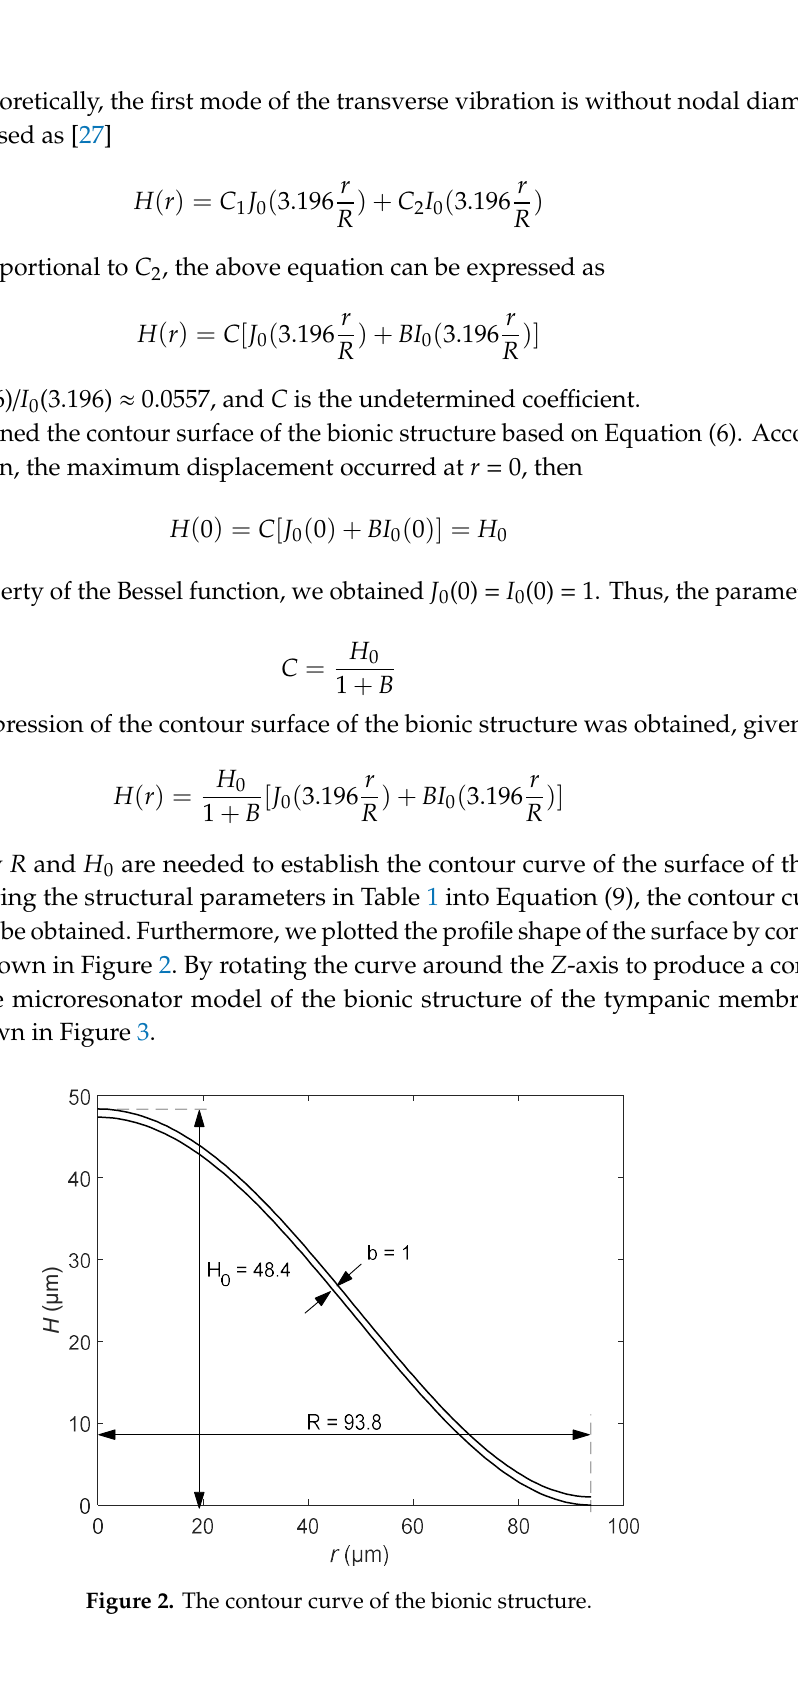
Figure 3. The three-dimensional model of the bionic structure of the tympanic membrane.